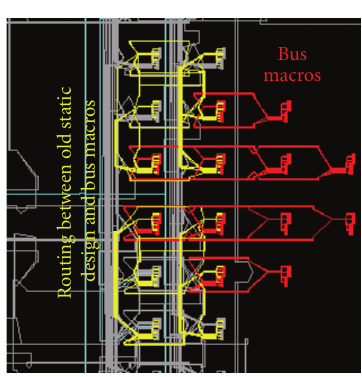
Figure 5: Routing between static design and bus macros.